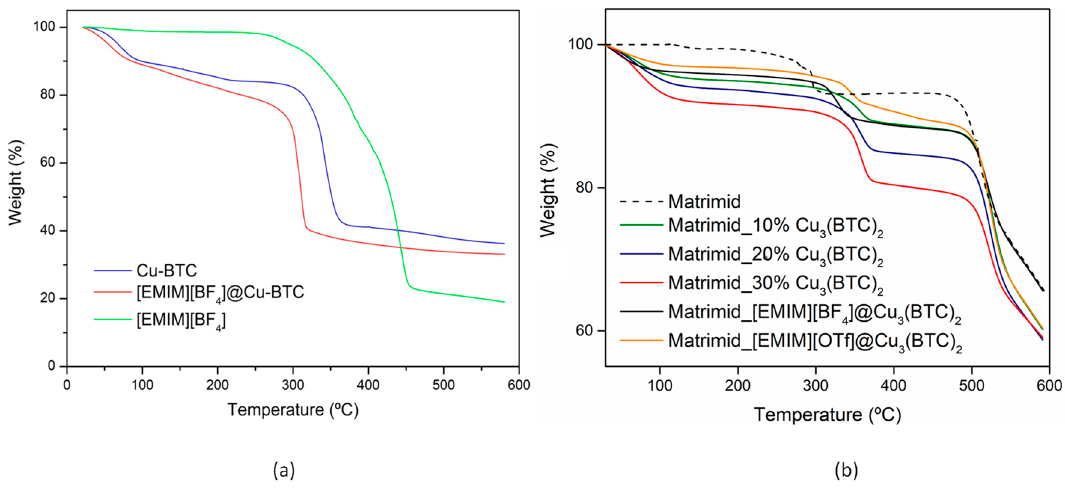
Figure 4. Thermogravimetric analysis ( a ) of [EMIM][OTf] (green line), Cu-BTC (blue line), and [EMIM][OTf]@Cu-BTC (red line) in the range 20 to 600 °C. The mixed matrix membranes (MMMs) ( b ).